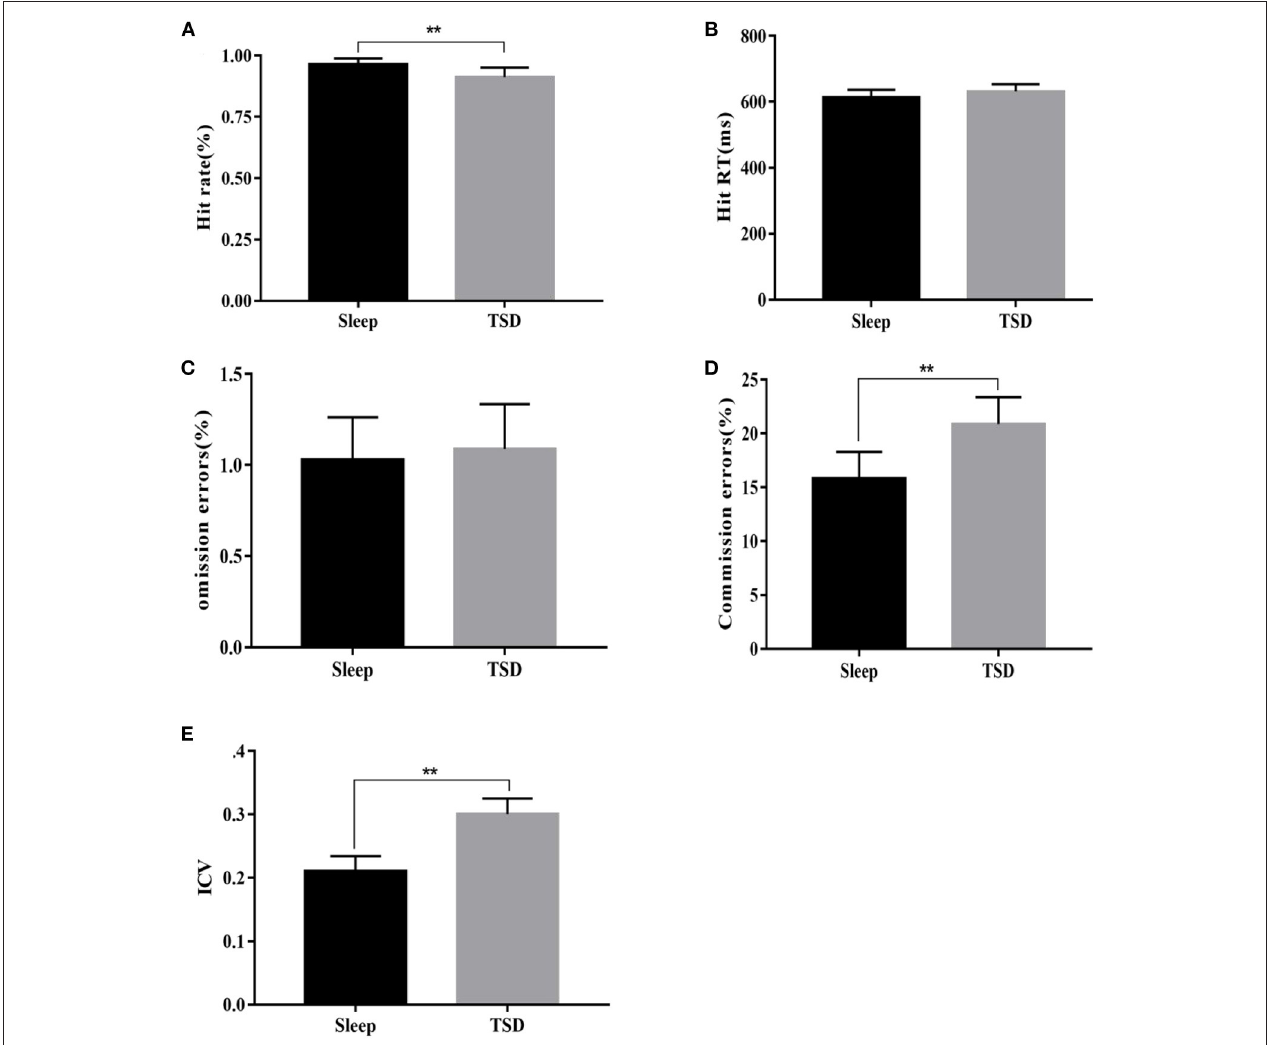
FIGURE 2 | Comparison of changes in various indicators of Go/Nogo task under sleep deprivation and normal sleep conditions. (A) Change in hit rate, (B) Change in RT, (C) Change in the number of omission errors, (D) Change in the number of commission errors, and (E) Change in ICV. ** p < 0.01.